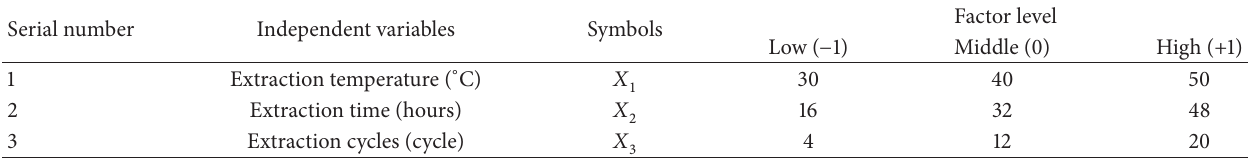
Table 1: Independent variables and their levels used in the response surface design.